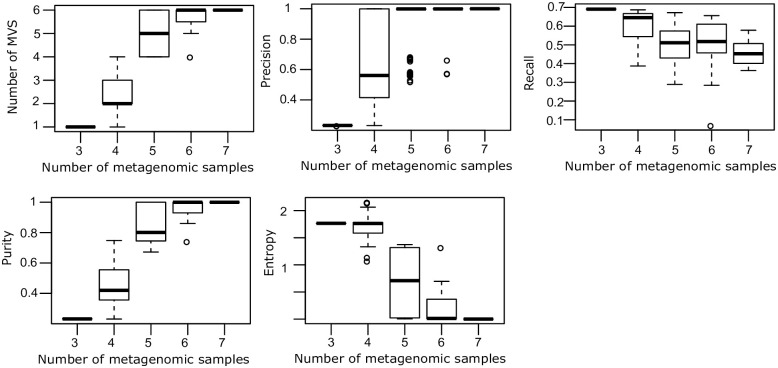
Sample size effect on metavariant clustering performances.